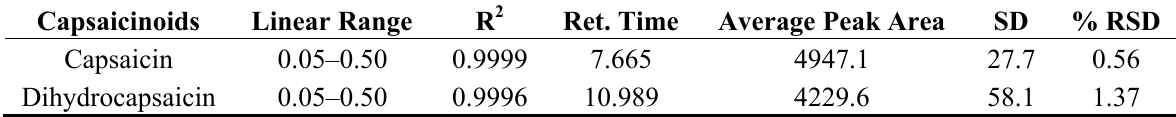
Table 1. Calibration data of the UFLC method for the determination of capsaicinoids